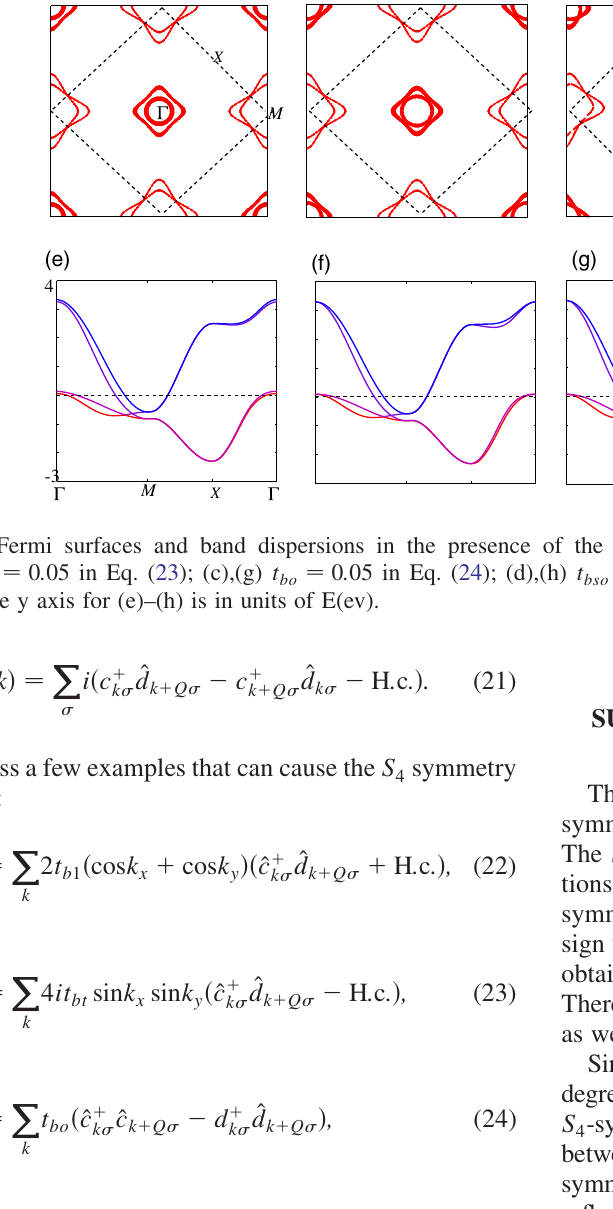
¼ 0 : 005 in Eq. (22); b 1